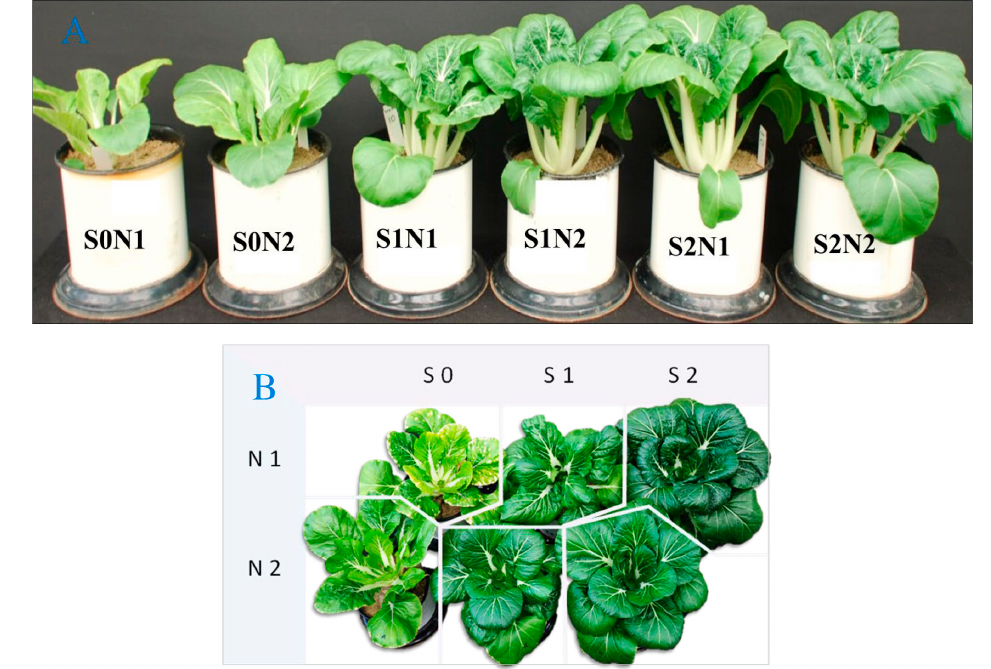
Fig. 2: Development of the biomass by means of varied nitrogen (N1 = 0.75 g N, N2 = 1.5 g N) and sulfur (S0 = 0 g S, S1 = 0.06 g S, S2 = 0.3 g S) fertilization in Pak Choi (A) side view (B) Top view. S deprivation (S0N1 and S0N2) caused the typical S-deficiencysymptoms, and decreased biomass. Increasing the S supply (0.06 and 0.3 g S pot -1 ) significantly enhanced the whole shoot biomass